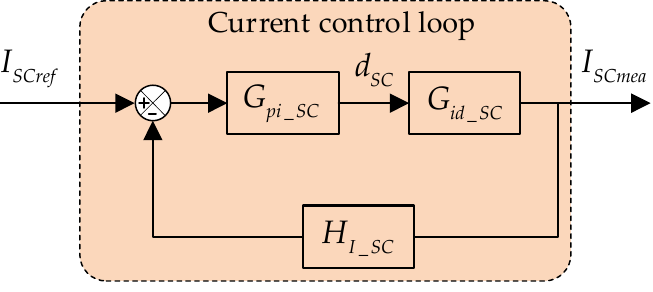
Figure 10. Current controller diagram of the SC converter.